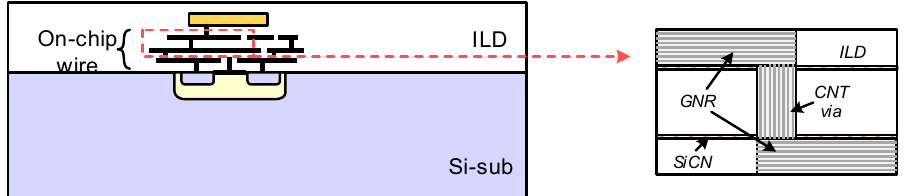
Figure 14. Schematic of all-carbon 3-D interconnect.